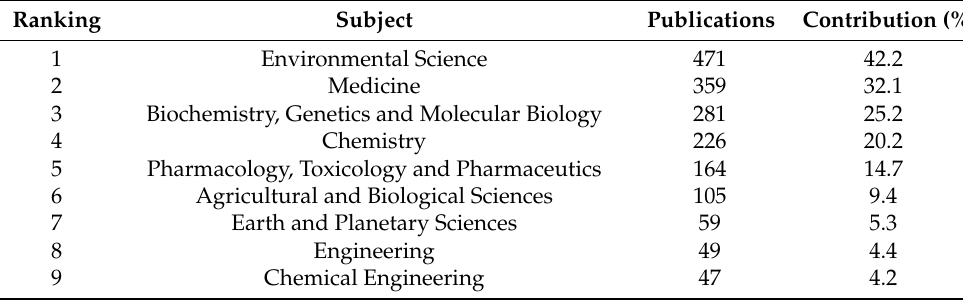
Table 4. The top 9 most popular subject categories (at least 30 documents).